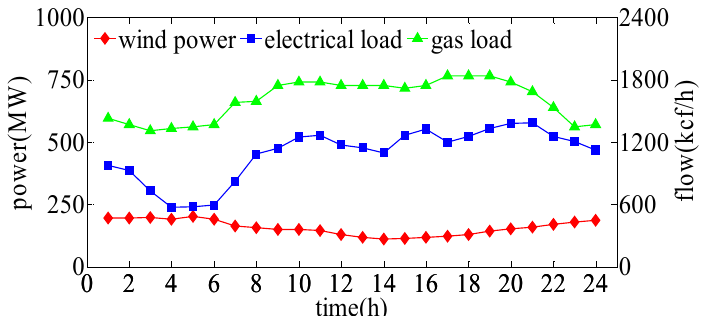
Figure 4. Forecast values of electricity load, gas load and wind power. In the figure, the green curve drawn by the triangle connection represents the forecast values of gas load; the blue curve drawn by the square connection represents the forecast values of electricity load; the red curve depicted by the diamond connection represents the wind power forecast values.